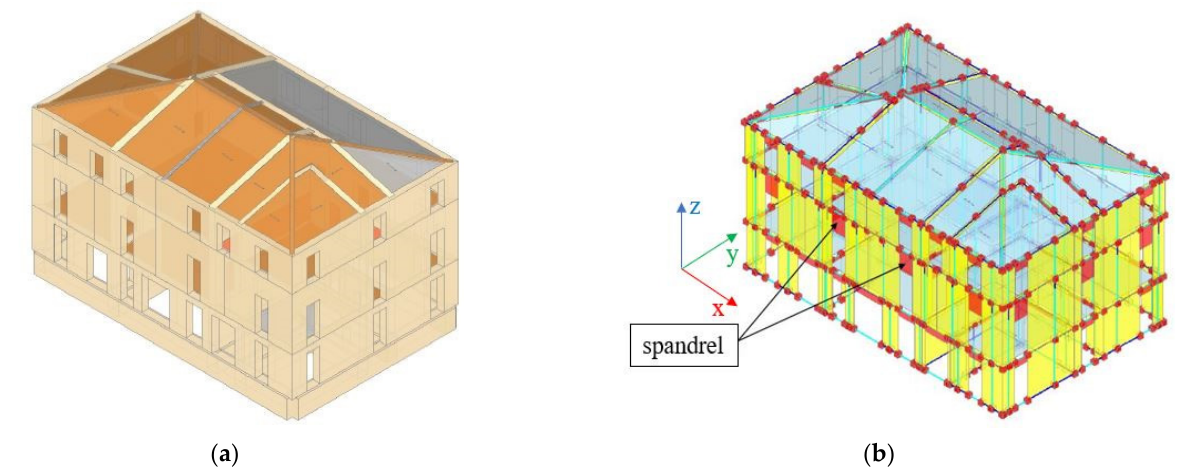
Figure 5. ( a ) 3D Finite Element model of the building; ( b ) Equivalent frame model.